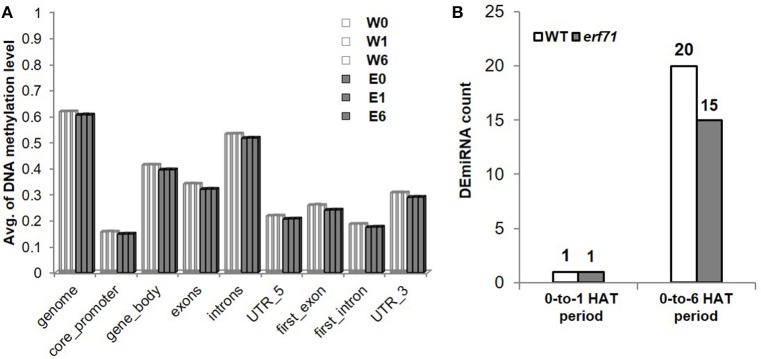
Profiles of miRNA and DNA methylation. (A) Average DNA methylation level of CpG sites in genomic regions. This shows that DNA was hypomethylated in erf71 but not significantly changed as the dehydration stress continued. (B) The number of differentially expressed micro RNAs (DEmiRNAs) at 0-to-1 and 0-to-6 h after treatment periods.